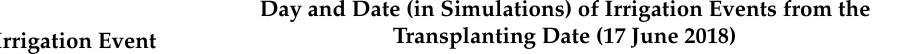
Table 1. Day and date of irrigation events in model simulations for different treatments.